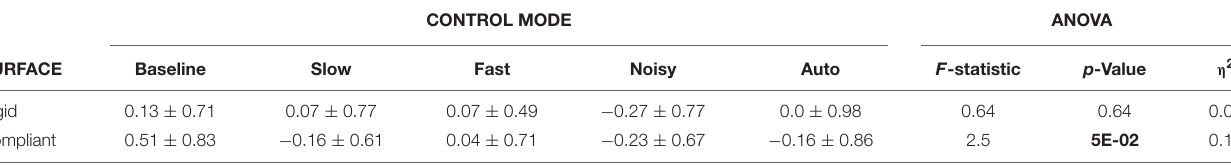
TABLE 4D | Mean explicit agency ( Likert scale: + 2 strongly agree to − 2 strongly disagree ) across control modes on rigid and compliant